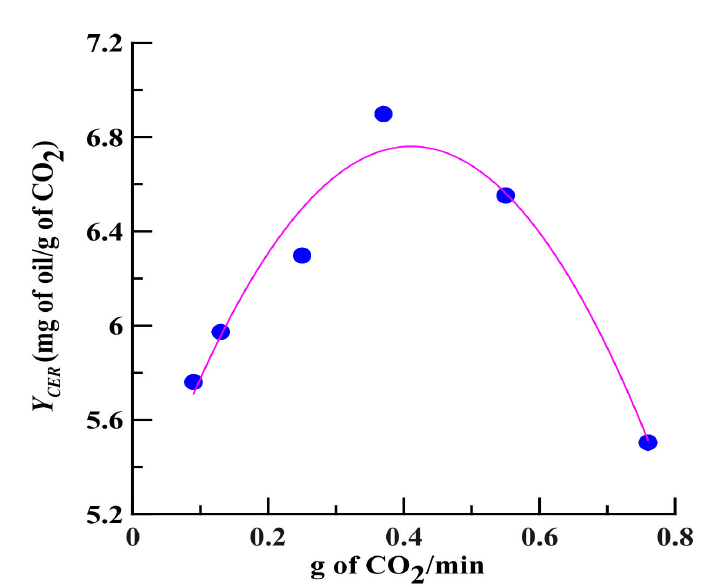
Figure 2. The effect of CO 2 flow rate on Y CER (mg of oil/g of CO 2 ) value at 32 ◦ C. The slope of the constant extraction rate (CER) period (a straight line) is defined as the Y CER value, which is obtained by dividing the yield by the solvent/plant weight ratio. If the solvent is saturated with the solute, YCER should be maximized; this value is called the theoretical solubility ( Y CER